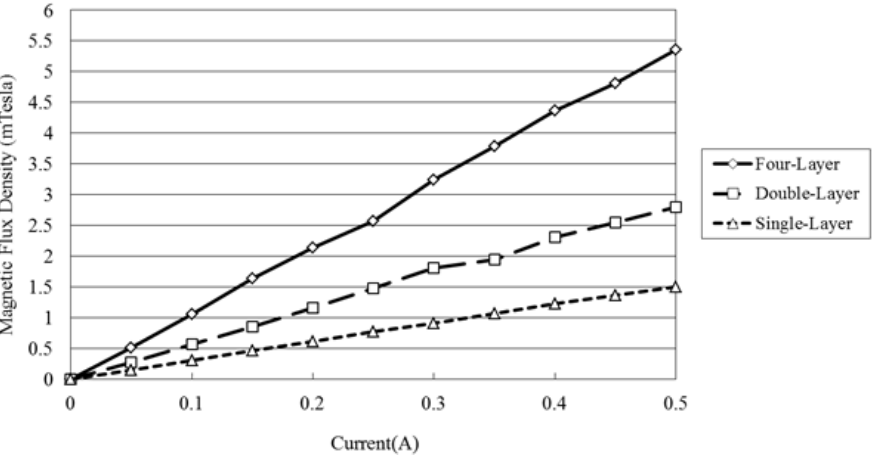
Figure 6. Variation of magnetic flux density produced at center of single-, double- and 1 four-layer microcoil stacks given input currents of 0~0.5 A.